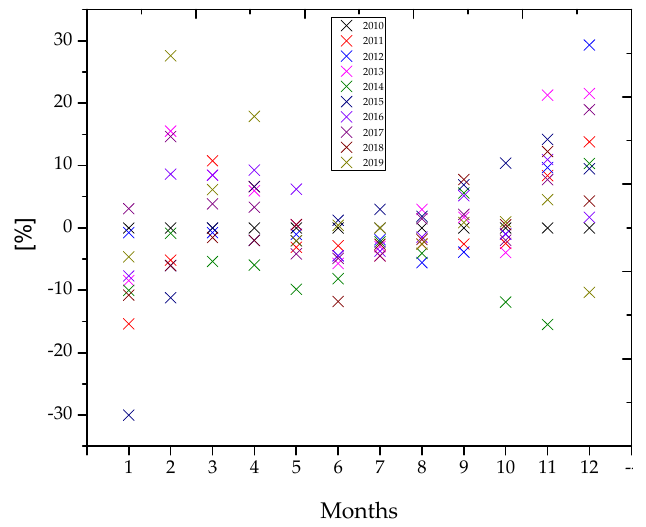
Figure 5. Monthly variation of temperature for 10-years period (actual data for Athens area) [88]. In order to calculate the PV energy production evolution over the period of analysis, the same climate data for the area of Athens are considered. In Figure 6, the 10-years period average energy production of the PV system per month in contrast to the monthly energy consumption of the building is presented.